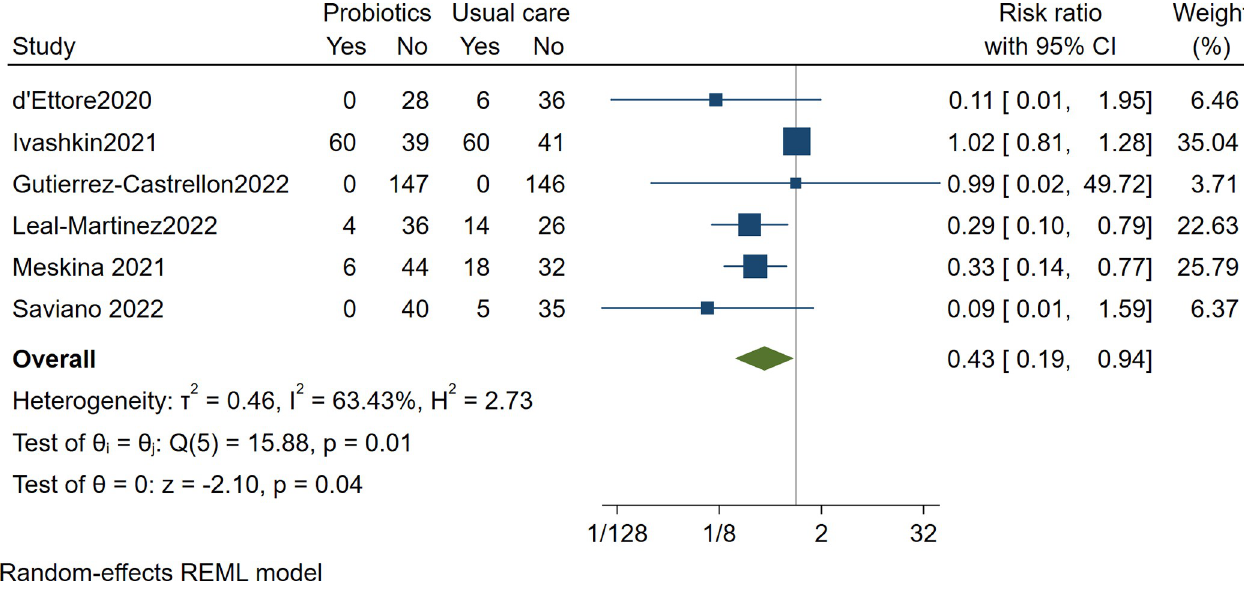
Fig 5. Composite clinical escalation or